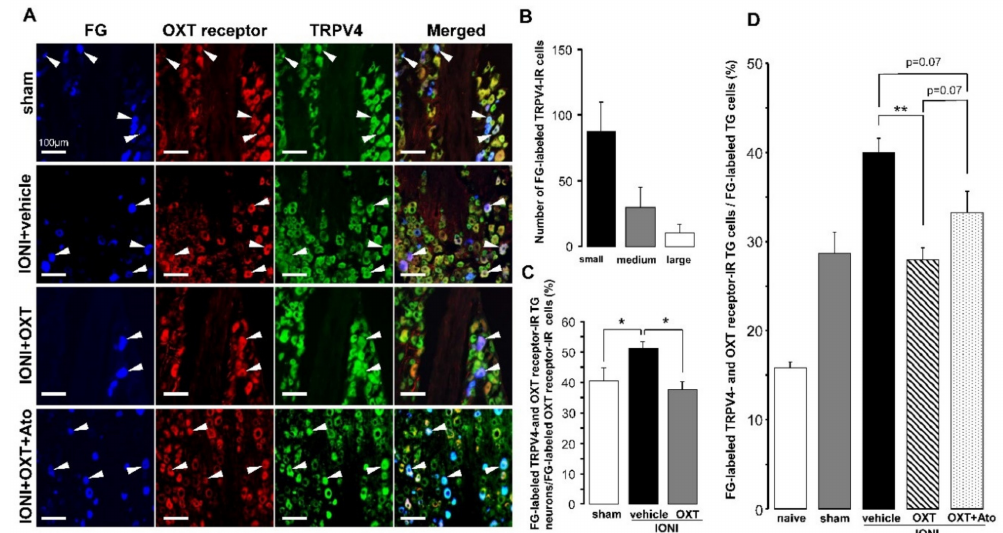
Figure 4. Transient receptor potential vanilloid 4 (TRPV4) and oxytocin (OXT) receptor expression in trigeminal ganglion (TG) neurons on day 5 after infraorbital nerve injury (IONI) treatment. ( A ) TRPV4- and OXT receptor-immunoreactive (IR) TG neurons innervating the whisker pad skin on day 5 after IONI treatment with vehicle, OXT, or OXT + atosiban administration. Arrowheads indicate fluoro-gold (FG)-labeled TRPV4- and OXT receptor-IR neurons. Scale bar: 100 µ m. ( B ) Number of FG-labeled TRPV4-IR TG neurons on day 5 after sham treatment. ( n = 4 in each group). ( C ) Mean percentages of FG-labeled TRPV4- and OXT receptor-IR TG neurons out of FG-labeled OXT receptor-IR TG neurons on day 5 after sham or IONI treatment with vehicle or OXT administration (sham, n = 5; IONI + vehicle, n = 4; IONI + OXT, n = 5). * p < 0.05. ( D ) Mean percentages of FG-labeled TRPV4- and OXT receptor-IR TG neurons in FG-labeled TG neurons on day 5 after sham and IONI treatment with vehicle, OXT, or OXT + atosiban administration. (naive, n = 5; sham, n = 5; IONI + vehicle, n = 4; IONI + OXT, n = 5; IONI + OXT + Ato, n = 6) ** p <